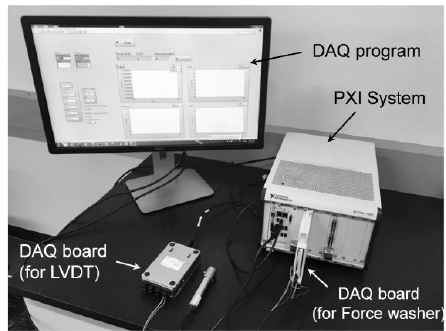
Figure 4. DAQ system for measuring both the displacement from LVDT and the preload from a washer-type load cell.